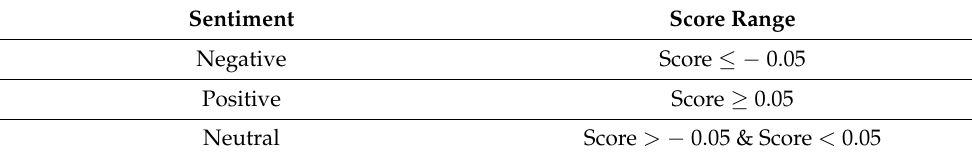
Table 5. Vader score